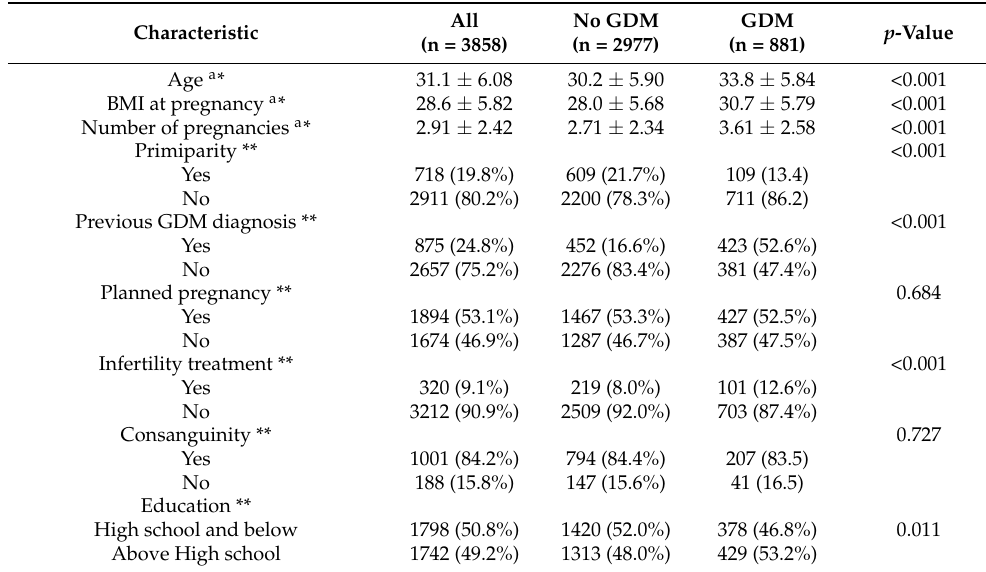
Table 1. Baseline characteristics of 3858 women by gestational diabetes mellitus (GDM) status in Al Ain,